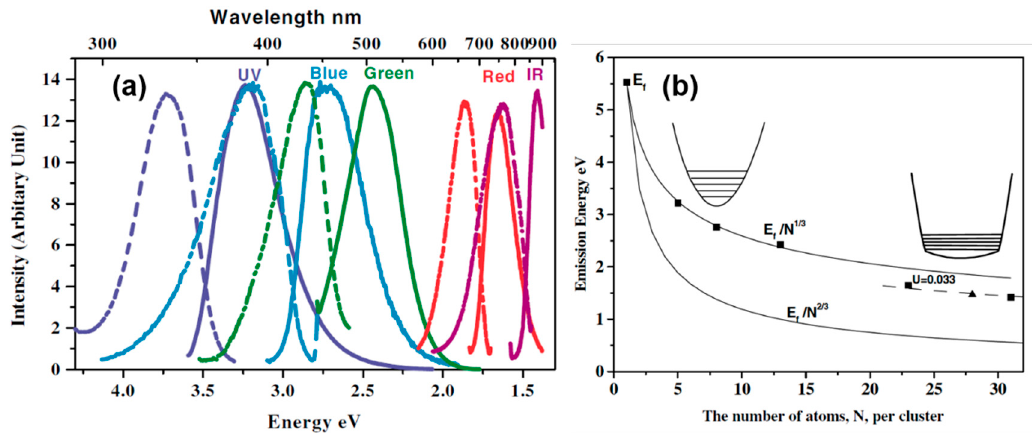
Figure 4. ( a ) Excitation (dashed) and emission (solid) spectra of different sizes of PAMAM-Au NCs. Excitation and emission maxima shift to longer wavelengths with increasing initial Au concentration, suggesting that increasing the nanocluster size leads to lower energy emission. ( b ) Correlation of the number of Au atoms per cluster (N) with the photoemission energy of Au NCs. Reprinted with permission from Ref. [26]. Copyright (2004) American Physical Society.